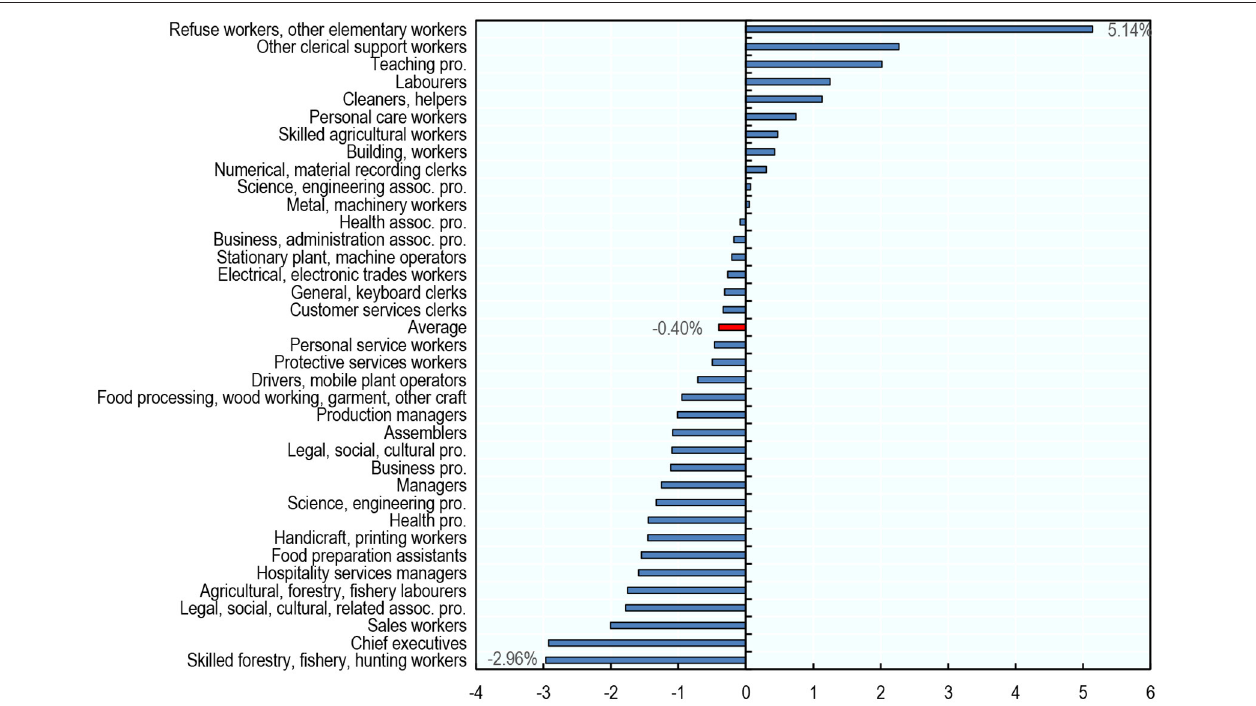
FIGURE 11 | Average usual working hours have decreased in most occupations between 2012 and 2019. Average percentage change in average usual weekly hours across countries by occupation, 2012–2019. Occupations are classified using two-digit ISCO-08. The averages presented are unweighted averages across the 22 countries analyzed (Mexico is excluded from the analysis of working time due to data availability). Usual weekly working hours by country-occupation cell are calculated by taking the average across individuals within that cell. Source: ENOE, EU-LFS, and